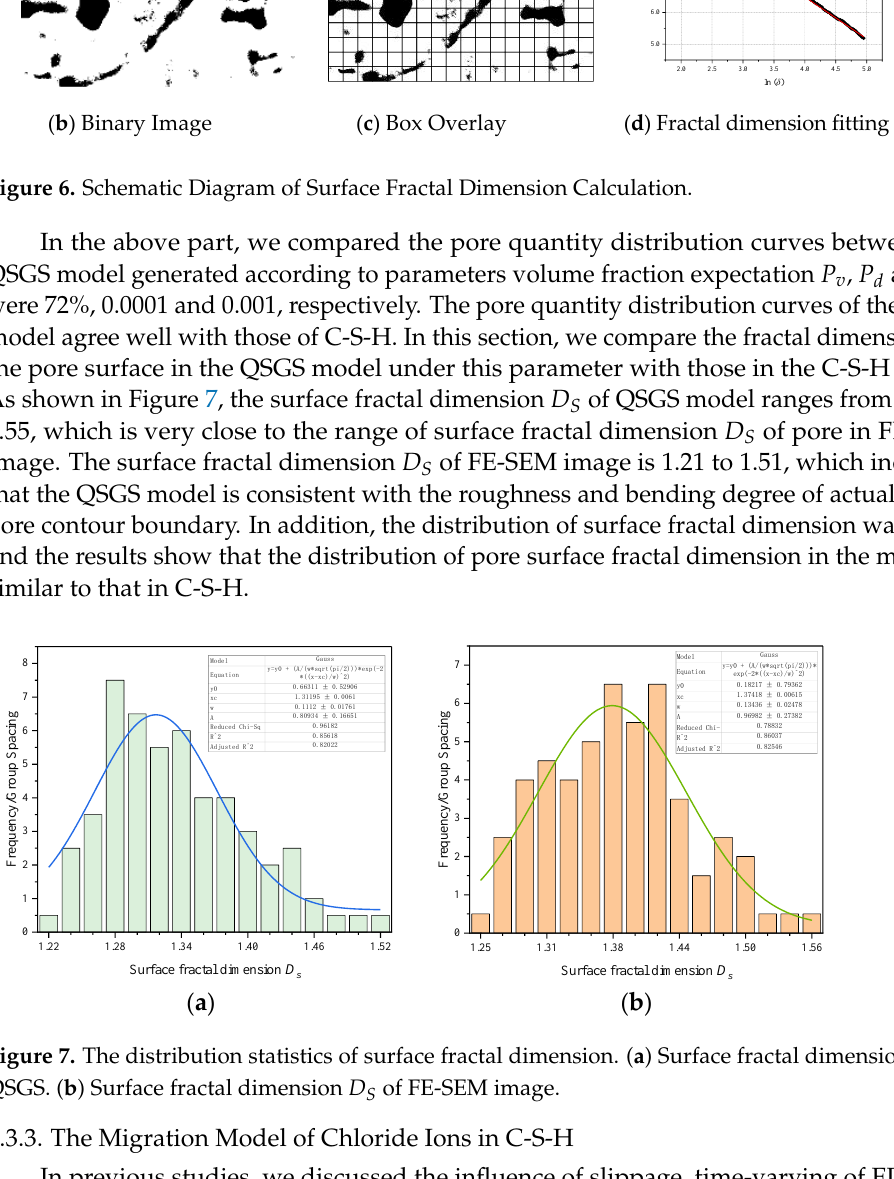
Figure 7. The distribution statistics of surface fractal dimension. ( a ) Surface fractal dimension D S of QSGS. ( b ) Surface fractal dimension D S of FE-SEM image.